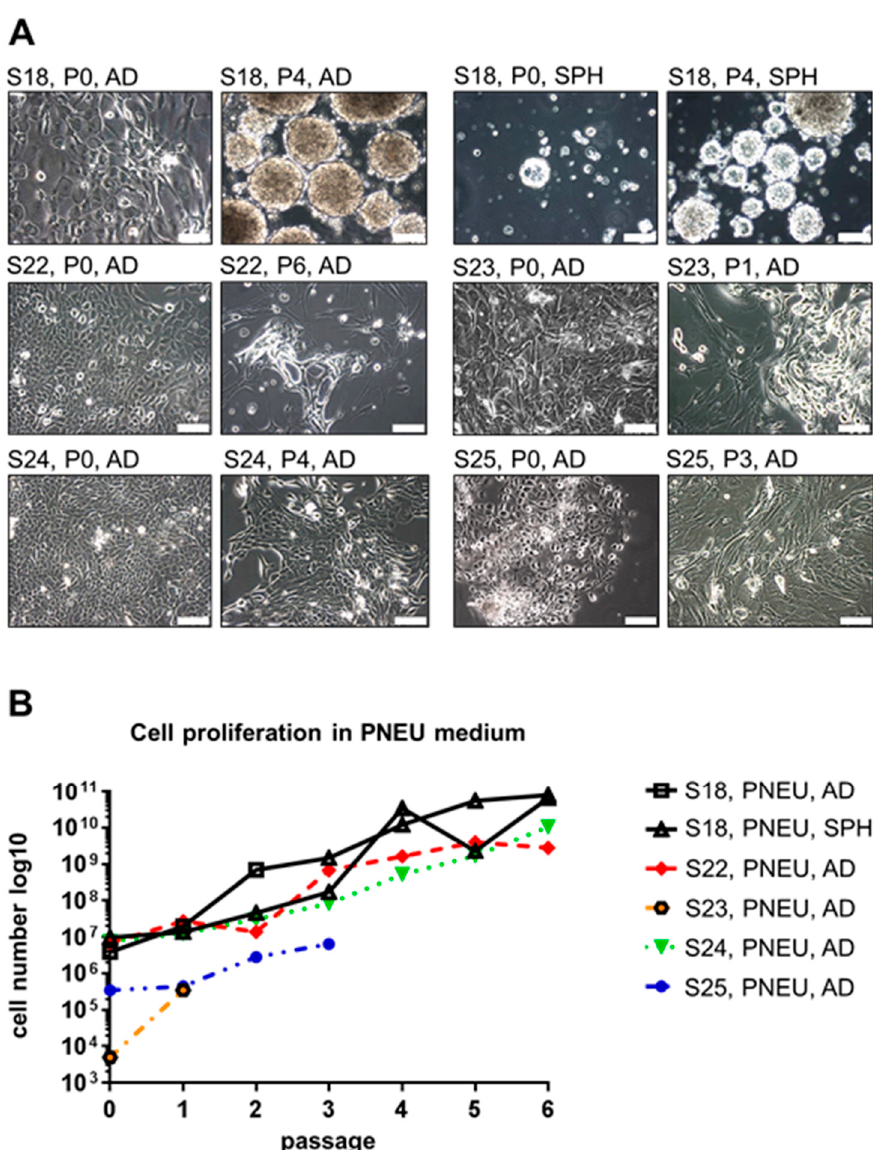
Figure 3. Primary HNSCC cell cultures in PNEU-medium. ( A ) Initial cultures in passage 0 (P0) and critical events observed in later passages: adherent S18 cells spontaneously transitioned into